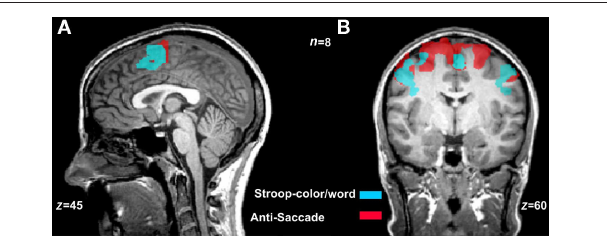
FIguRe 1 | Overlapping activations during the Stroop-color/word and the anti-saccade tasks. Color maps are overlay activations from incongruent and congruent blocks during the Stroop task (blue map) and the anti-saccade and pro-saccade trials (red map) during the anti-saccade task [ n = 8, p (Bonferroni ) < 0.0001]. (A) The frontal regions activated during the classical Stroop-color/word task included the more anterior areas of pre-supplementary motor area (preSMA) and supplementary eye fields (SEF). (B) The active neural network during the anti-saccade task was similar to that of the Stroop-color/word task, with the addition of frontal eye fields